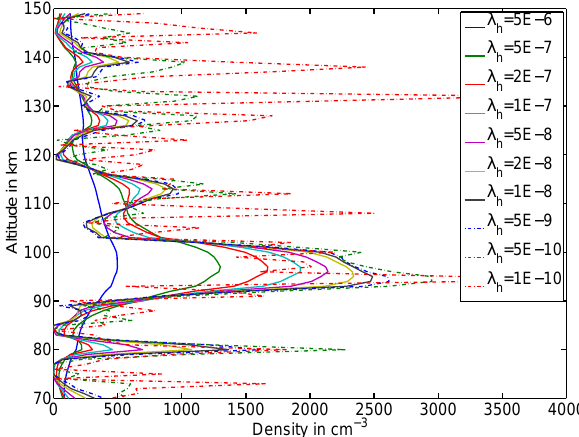
Fig. 26. Single day (7 September 2009) result for Mg + (279.6nm) in the equatorial region from 15 ◦ S to 15 ◦ N. The same approach to find the optimal constraint strength for Mg (see Fig. 25) is applied for Mg + . However, the variation of the peak density with constraint strength, especially for low strength, is much weaker, so errors from a wrong choice of the constraint strength are smaller. For Mg + the solution with λ h = 1 × 10 − 7 will be used for further investigations.